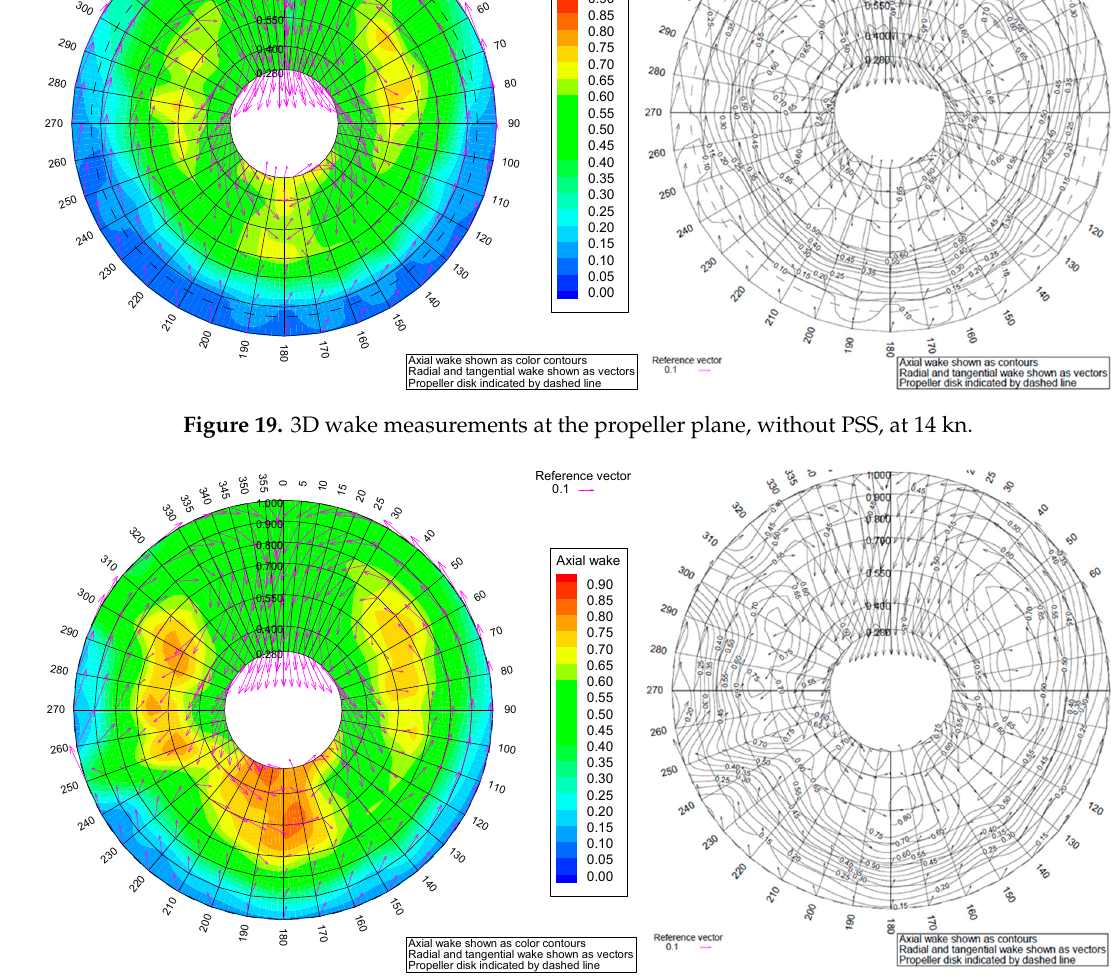
Figure 20. 3D wake measurements at the propeller plane, with PSS, at 14 kn.